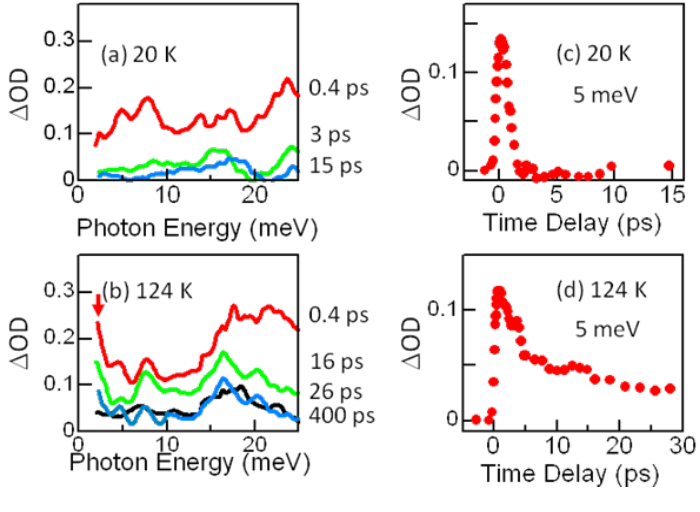
Figure 12. ( a , b ) Transient absorption (  OD) spectra in α-(ET) THz region ( E = 0.89 eV, I = 0.03 mJ/cm 2 ); ( c , d ) Time evolutions detected at ex ex 5 meV [( c ) 20 K; ( d ) 124